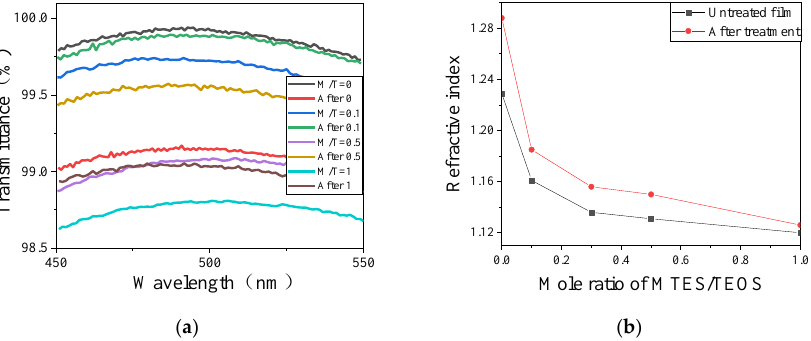
Figure 1. The transmittance spectra ( a ) and refractive index ( b ) of a series molar ratio of M/T film and the film after treatment.